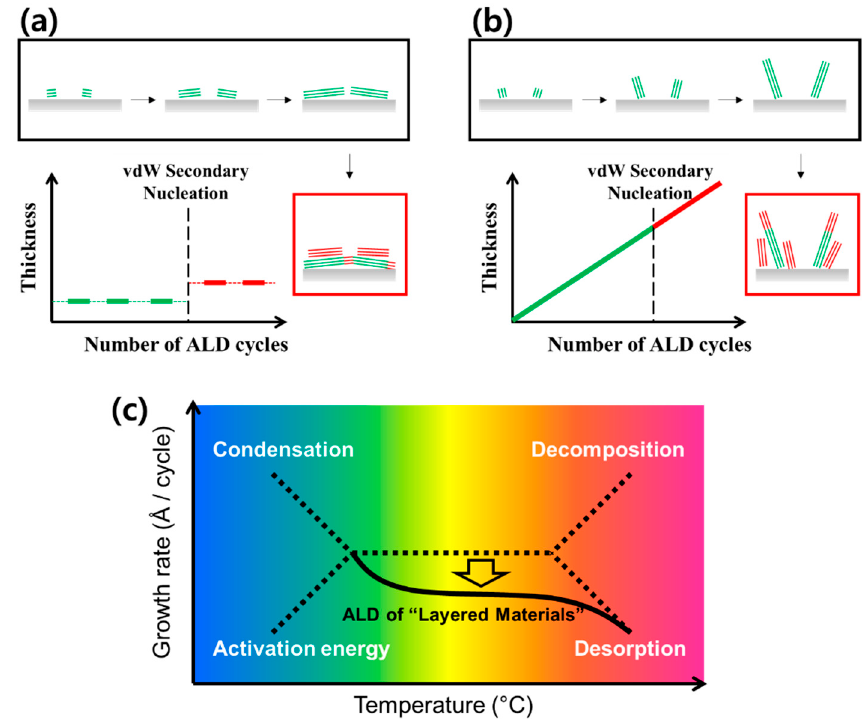
Figure 12. ( a , b ) Two distinctive growth modes of layered materials, such as MoS 2 grown by atomic layer deposition (ALD). ( c ) Plot of the so-called “ALD window” with four factors affecting the nonideality of the ALD processes (i.e., condensation, decomposition, activation energy, and desorption). An incomplete reaction occurs because the activation energy for the reaction is not reached; adsorbed precursors on the surface react with the next precursor and remove the residue. However, there is not enough heat energy due to low chamber temperature so residues cannot be removed and remain as condensation; high temperature decomposes the precursor even before absorbing on the surface, and causes CVD-like deposition; the deposited compounds are desorbed because of excessive heat energy in the chamber). This plot revisits the ALD process of layered materials by adding an additional factor, i.e., strong structural anisotropy (see solid black line). Adapted from reference [76]. Copyright (2017) American Chemical Society.